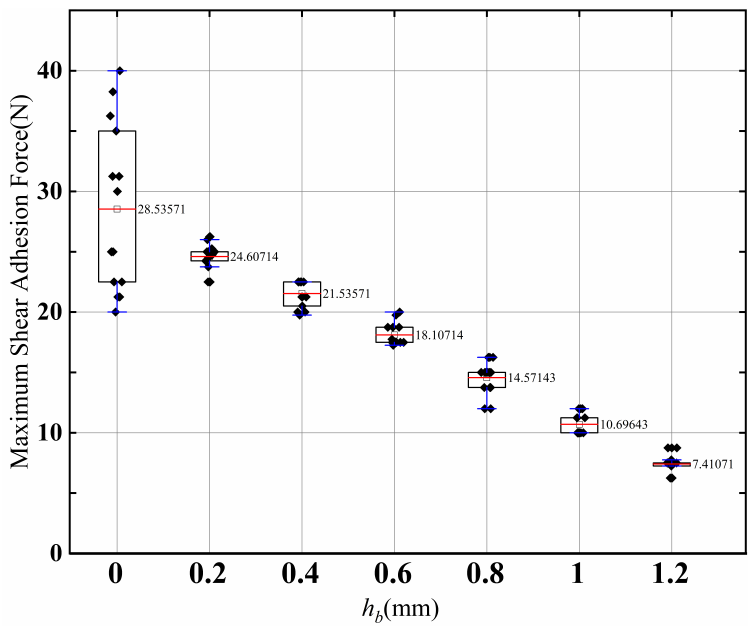
of the preload resulting in incomplete contact between the cavity and the target surfaces.